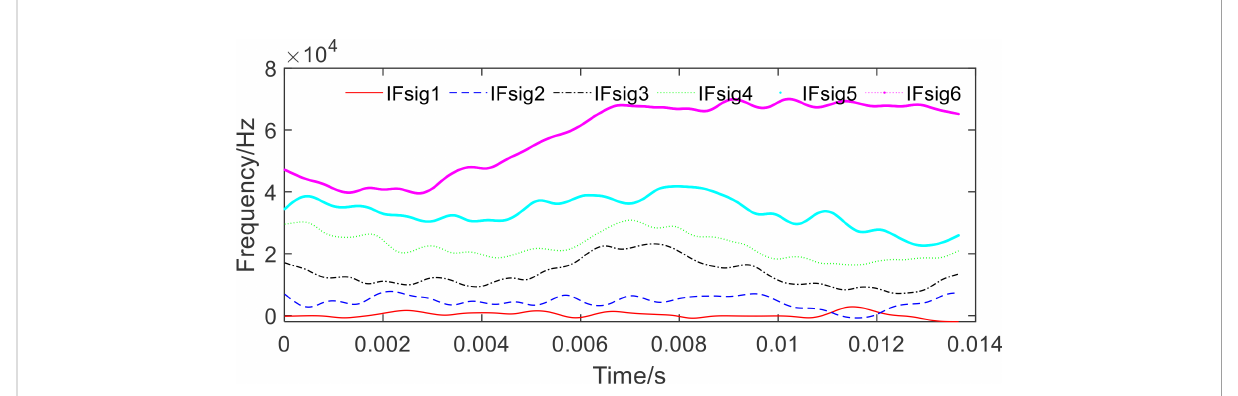
FIGURE 11 The TF diagram of the estimated components using the proposed approach.